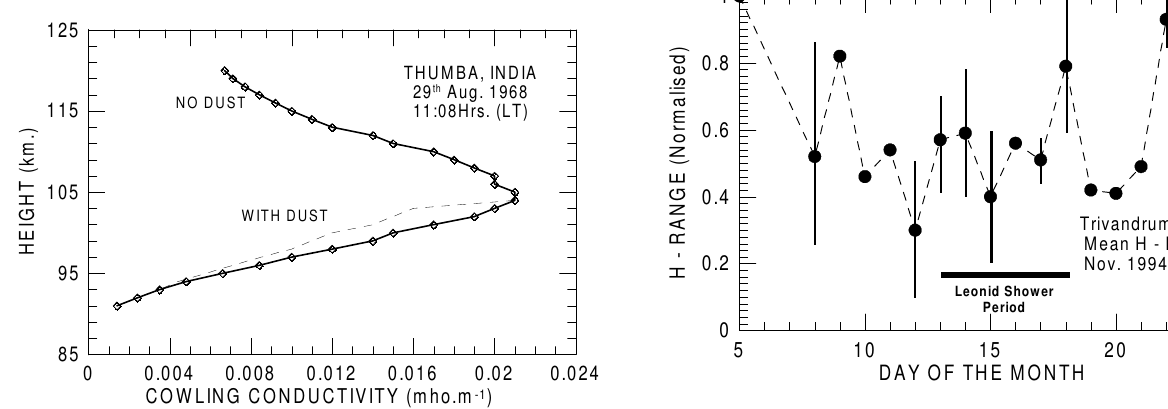
Fig. 6. Height profile of the Cowling conductivity on 29 August 1968 at 11:08 LT with and without an assumed charged dust layer.